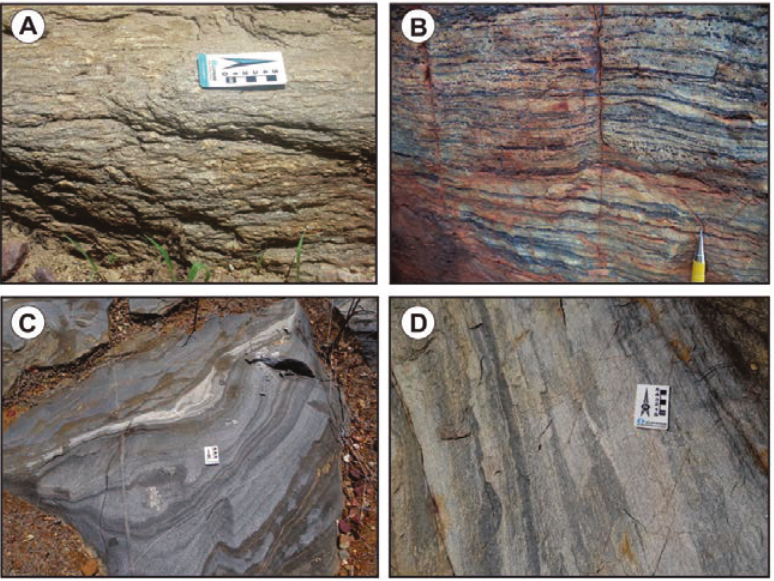
Figure 4 - Field features of the rocks around the Saquinho mine: (A) augen gneiss with stretching lineation given by potassic feldspar crystals; (B) banded iron formation; (C) marble with banding formed by white, light and dark gray levels; (D) biotite (amphibole) paragneiss with alternating whitish and light gray